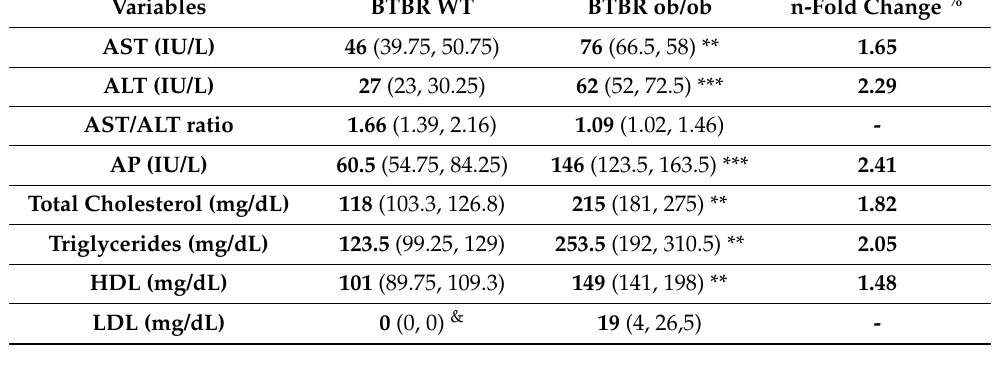
Table 1. Metabolic and biochemical parameters in BTBR WT and BTBR ob/ob at 12 w. Data are shown as Median (IQR). ** p < 0.01; *** p < 0.001 vs. BTBR WT. Abbreviations: AST: aspartate amino- liver at 12 weeks in BTBR WT (left) and BTBR ob/ob mice (right). ( D ) Measurement of liver TGs at transferase; ALT: alanine aminotransferase; AP: Alkaline Phosphatase; HDL-C: high-density lipoprotein 12 weeks. ( E ) NAFLD activity score (NAS) assessment at 12 weeks ( F ) Representative H-E images cholesterol LDL-C: low-density lipoprotein cholesterol. & Undetectable. % n-fold change vs. BTBR WT. of livers of BTBR WT (left) and BTBR ob/ob mice (right) showing steatosis progression (magnifica- tion 100×) from 4–12 weeks. ( G ) Semi-quantitative determination of steatosis, lobular inflammation and hepatocytes ballooning in livers of mice at 12 weeks. Data are shown as scatter dot plots and mean ± SEM of each group ( n = 5–6 mice/group); * p < 0.05, ** p < 0.01, *** p < 0.001 vs. BTBR WT.